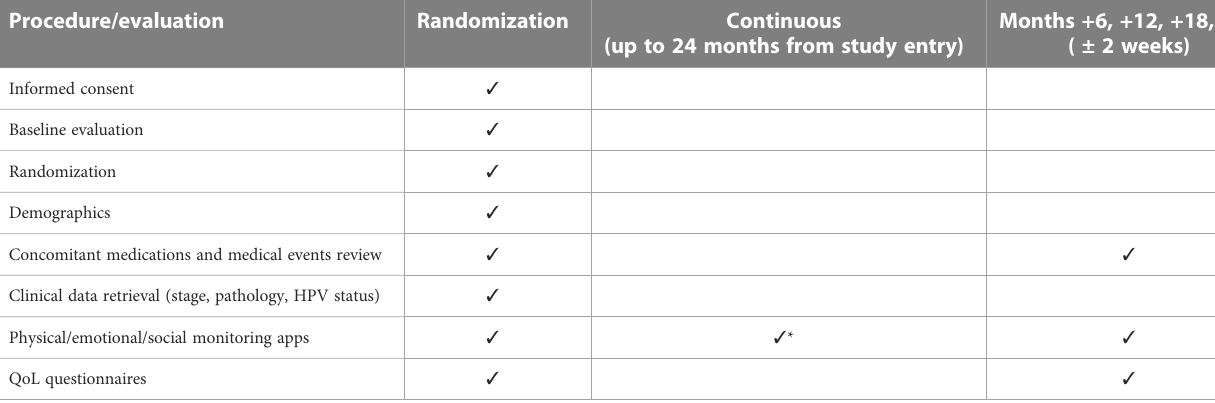
TABLE 4 Study fl owchart.